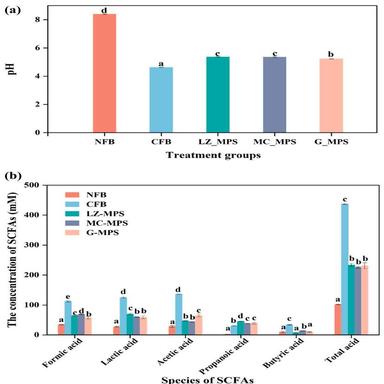
The final pH (a) and concentrations of SCFAs (b) after in vitro fermentation for 24 h. Different letters indicate significant difference (P < 0.05) among different groups.